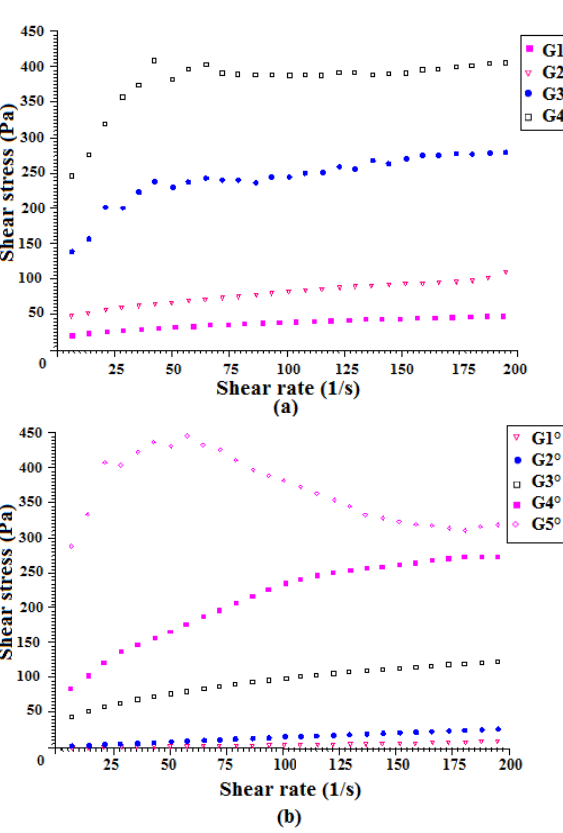
Figure 15: Effect of LF content on the evolution of the shear stress with shear rate (a) without Sp and (b) with Sp of the cement grout.